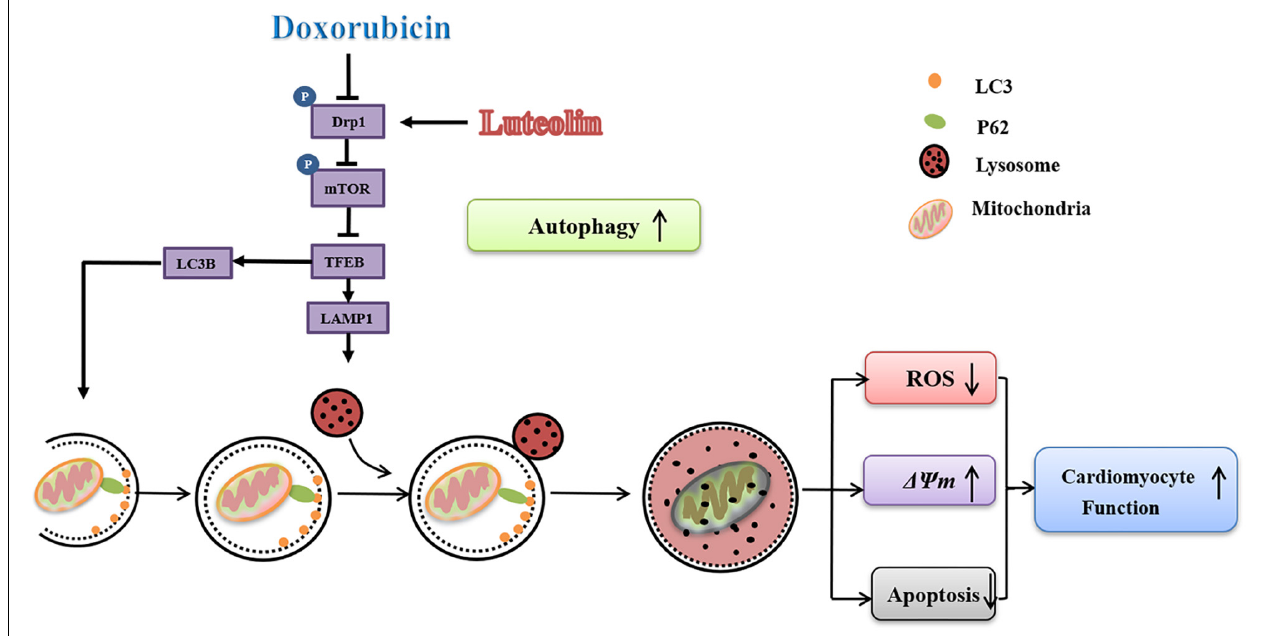
FIGURE 8 | Scheme illustrating proposed possible mechanism of action for luteolin. Doxorubicin challenge inhibits autophagy through disrupting formation of autophagosome and suppressing lysosomal generation in association with changes in Drp1/mTOR/TFEB signaling cascade. Luteolin treatment effectively facilitates autophagosome formation, and improves lysosomal function possibly through a Drp1/mTOR/TFEB-dependent mechanism, resulting in alleviation of ROS accumulation, (cid:49)(cid:57) m collapse and apoptosis upon doxorubicin